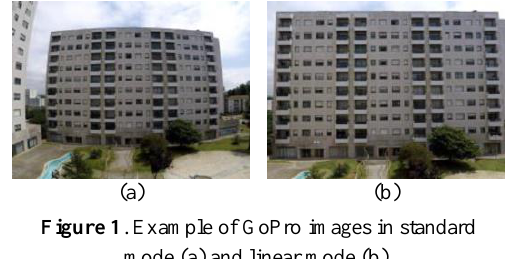
Figure 1 . Example of GoPro images in standard mode (a) and linear mode (b).